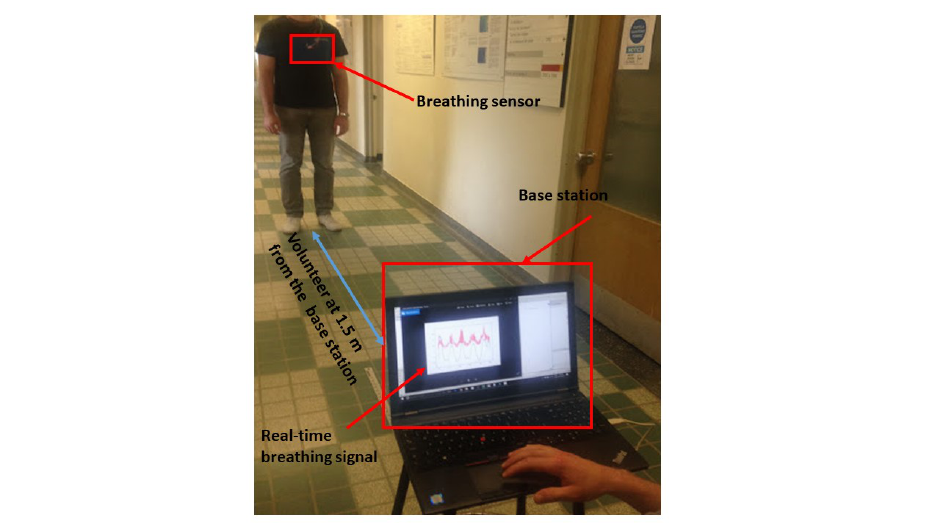
Figure 7. Experimental layout: volunteer wearing the smart textile and standing up in front of the base